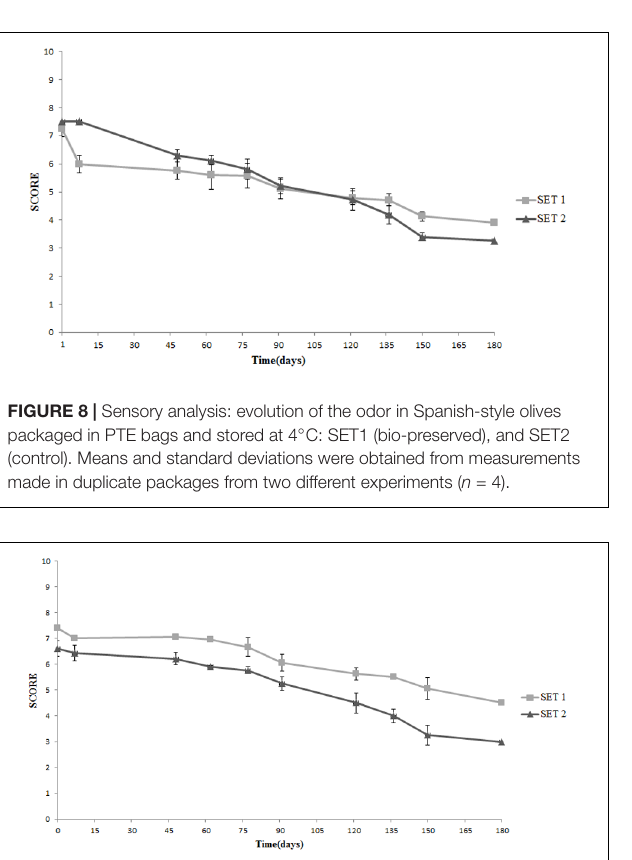
FIGURE 7 | Sensory analysis: evolution of the color in Spanish-style olives packaged in PTE bags and stored at 4 ◦ C: SET1 (bio-preserved), and SET2 (control). Means and standard deviations were obtained from measurements made in duplicate packages from two different experiments ( n = 4).